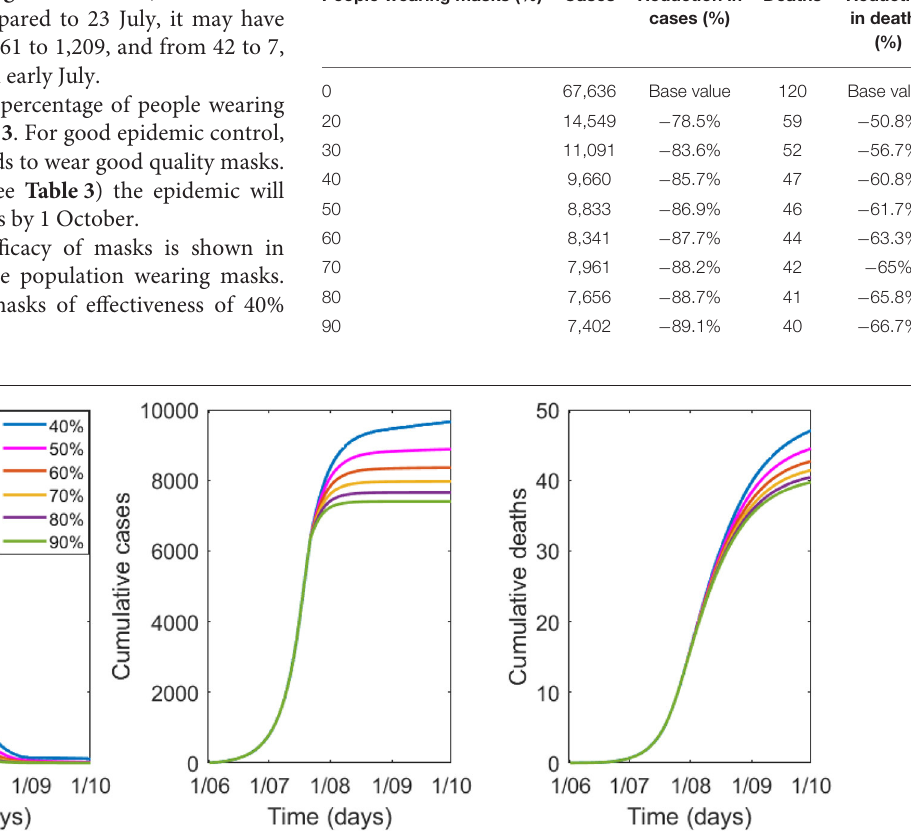
TABLE 3 | Modeled cases and deaths by 1 October by percentage of the population wearing masks of 67% efficacy. People wearing masks (%) Cases Reduction in cases (%)